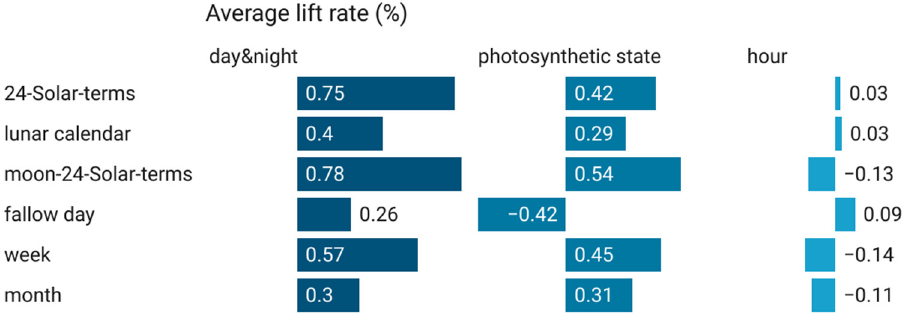
Figure 15. Average increase in the R 2 of the model (polynomial encoding).